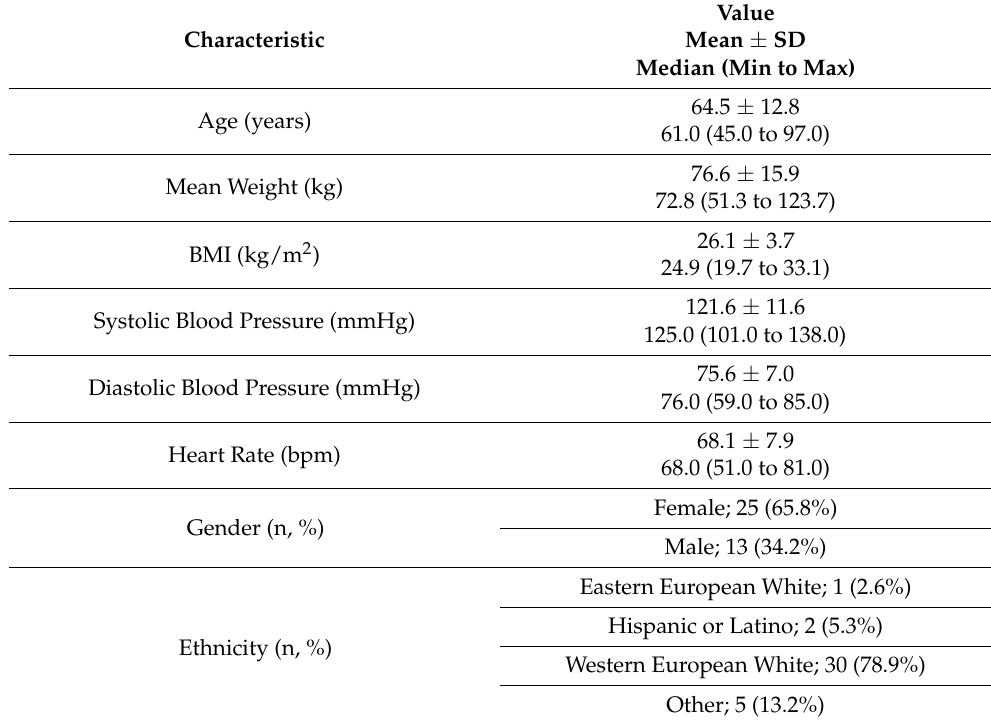
Table 1. Participant demographic and anthropometric data.